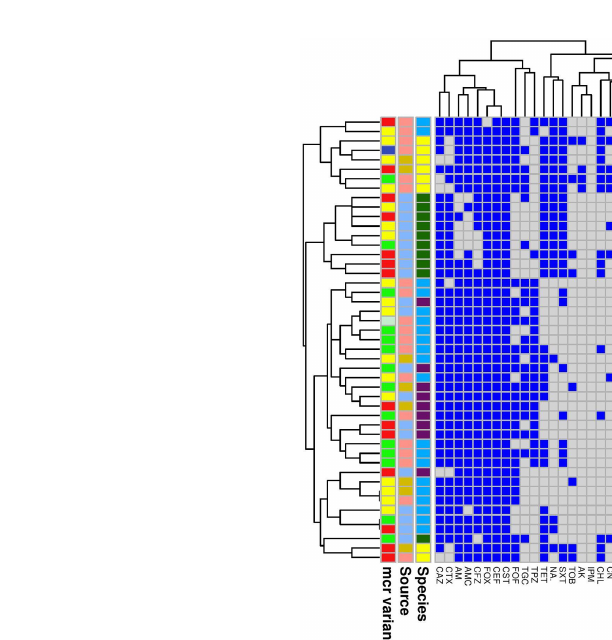
Frontiers in Cellular and Infection Microbiology |